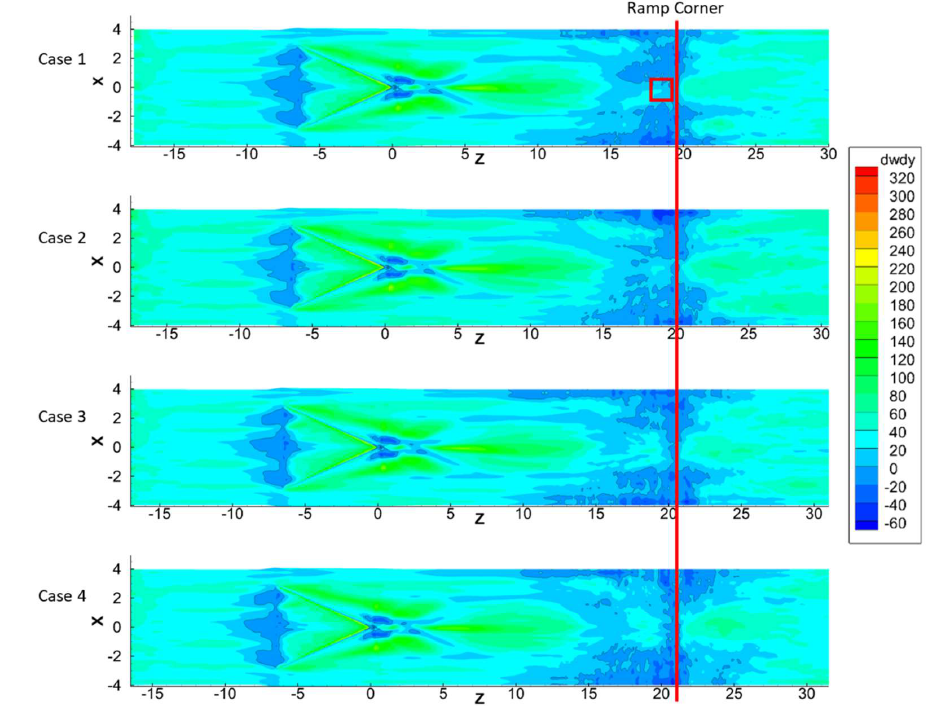
Figure 12. The flow separation in time-averaged view of four cases.